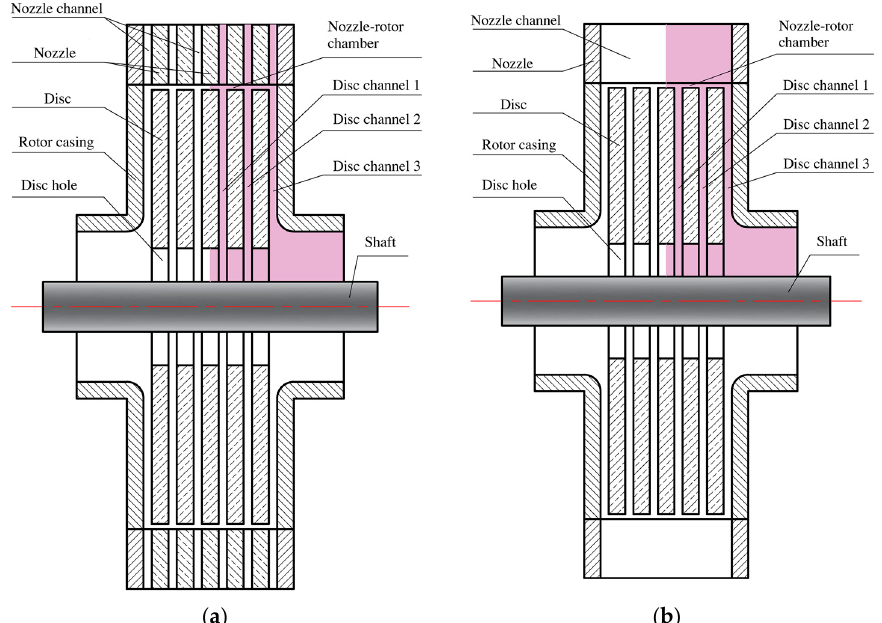
Figure 2. Sketch maps of multichannel Tesla turbines: ( a ) one-to-one Tesla turbine; and ( b ) one-to-many Tesla